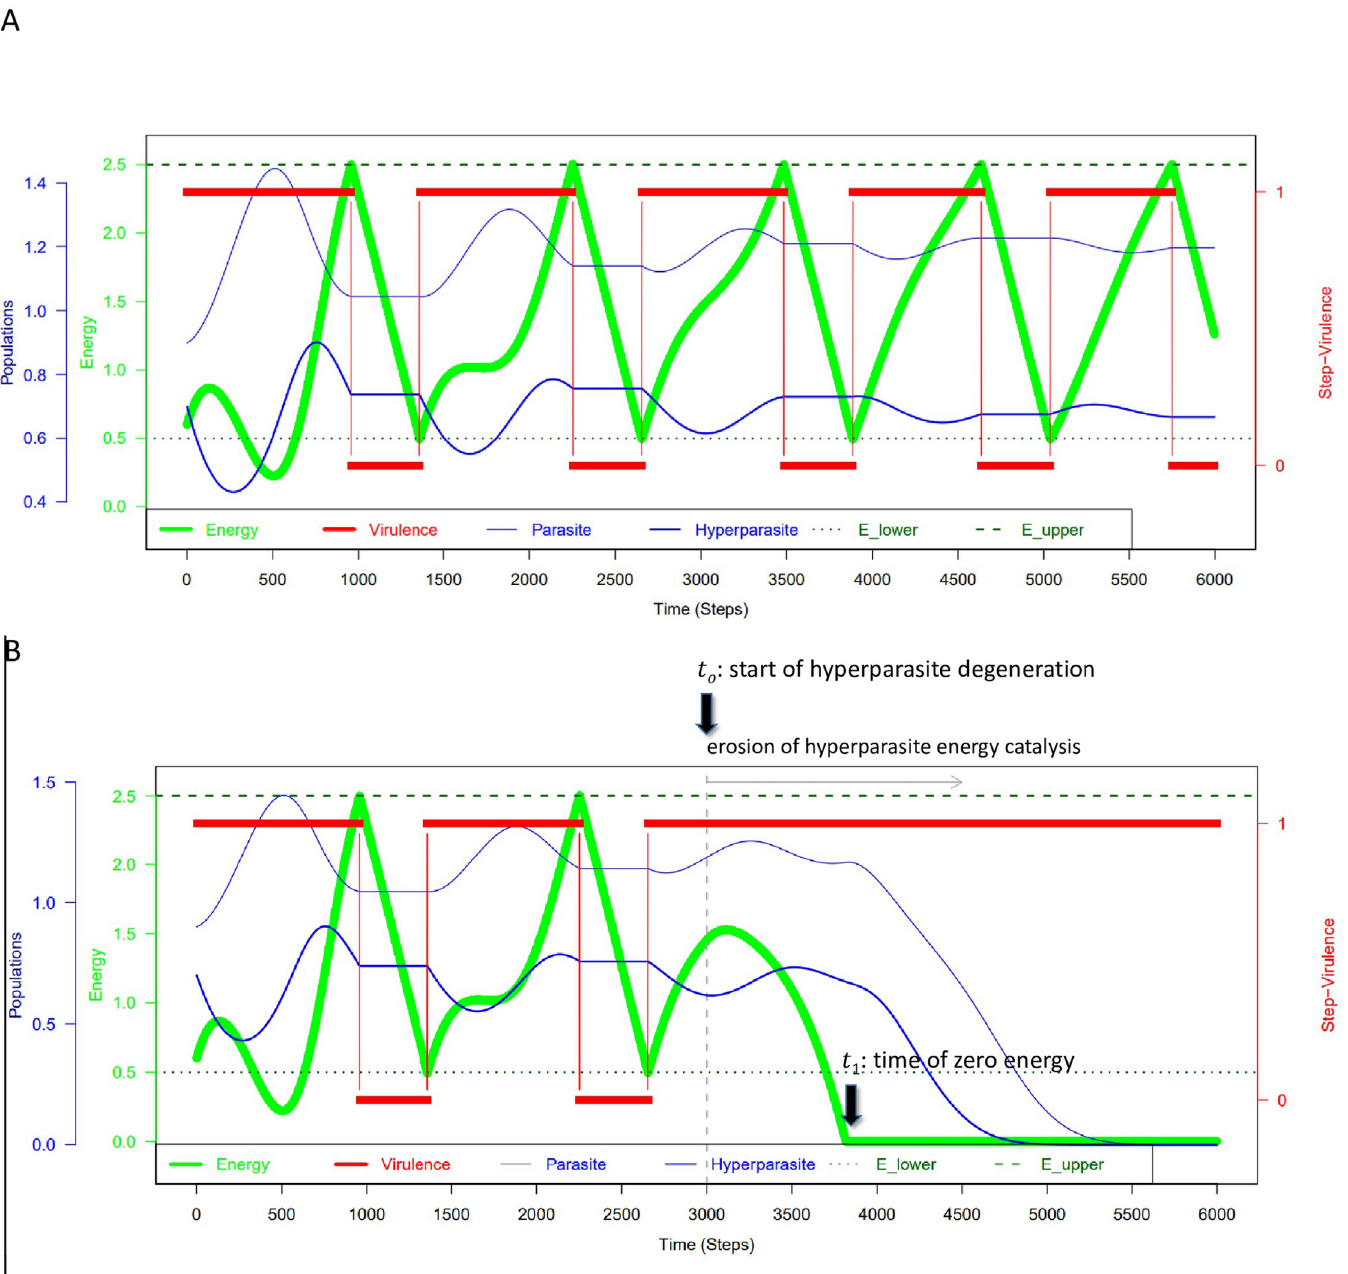
Fig 2. One energy, one host-nested parasite unit homeostasis model. (A) The model is extended by adding a hyperparasite Y (phage, dark blue) to the parasite X (bacteria, light blue) in order to form the host-nested parasite unit, limited to one single energy ( E = E 1 , in light green) that has two levels, E lower and E upper ( E lower dotted line in dark green, E upper dashed line in dark green). (B) Hyperparasite degeneration is modeled starting at t ! t to illustrate the ensuing energy decline caused by the 0 1 absence of newly generated catalytic energy. https://doi.org/10.1371/journal.pone.0281661.g002 β > 0 is the rate of energy consumption of parasite X when virulent, γ > 0 is the rate of catalytic energy production of hyperparasite Y when virulent.